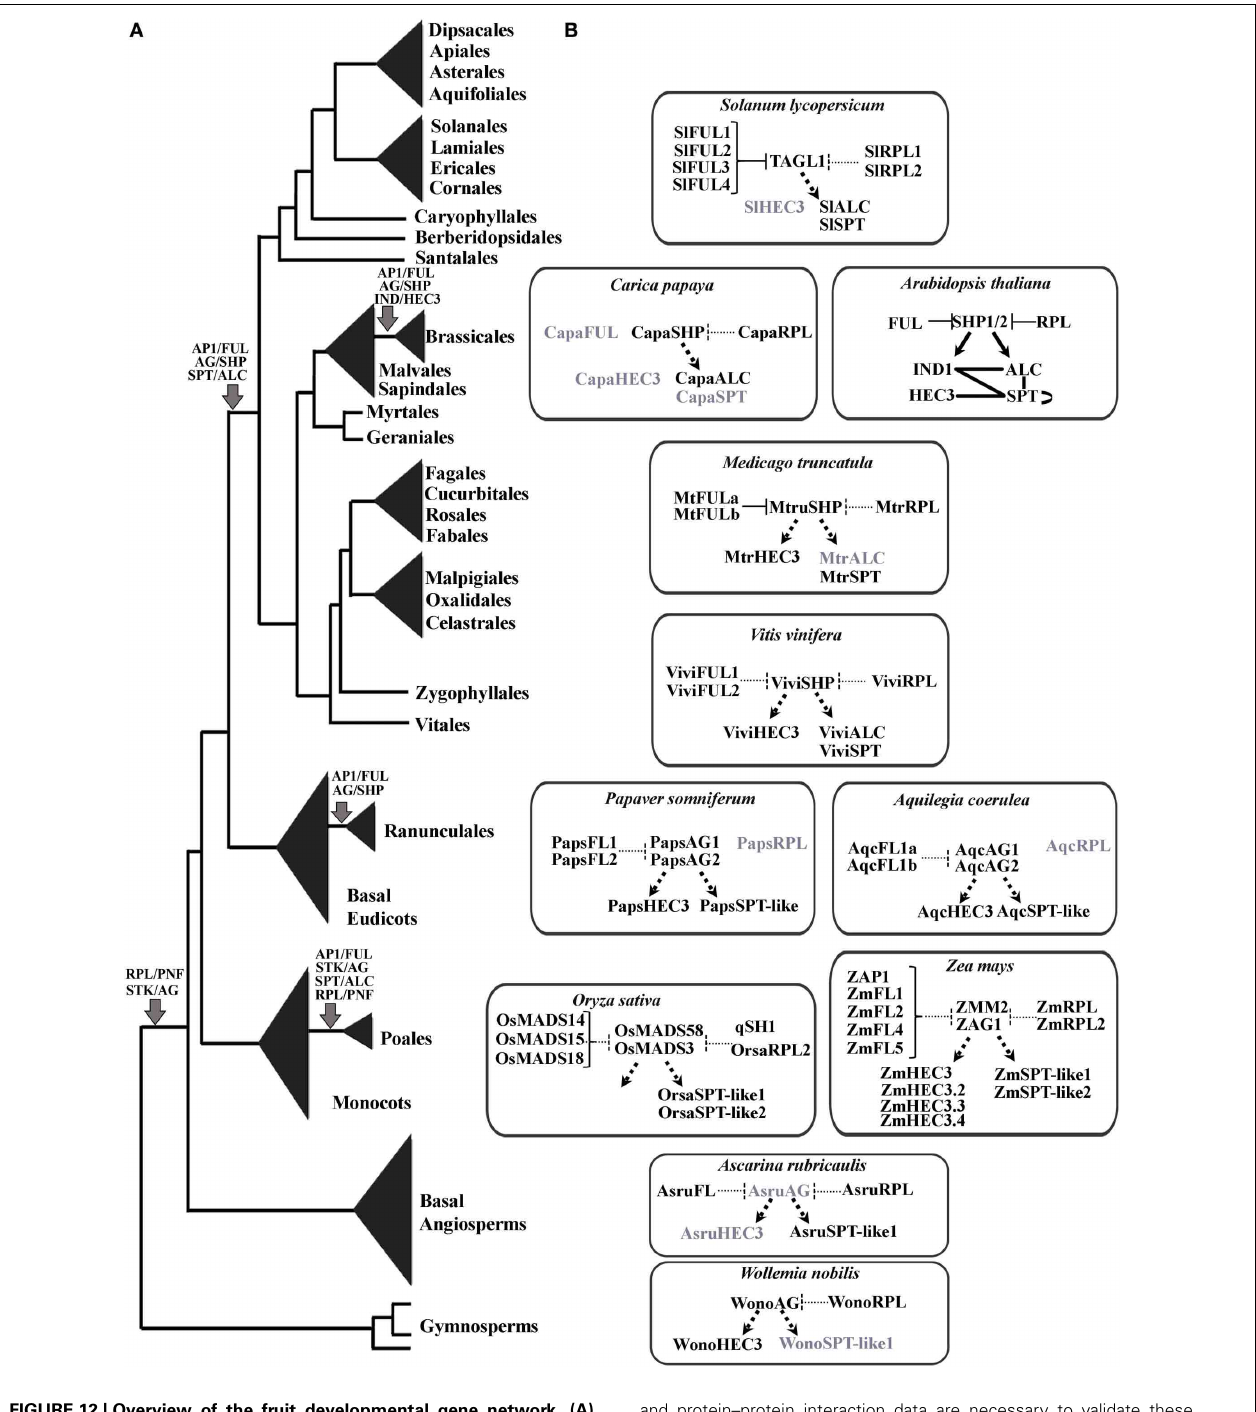
and protein–protein interaction data are necessary to validate these hypothetical interactions. Proteins in black are those previously identified or recovered in our analyses. Proteins in gray were not recovered from databases and may have been lost in the respective taxa. Solid black lines, validated protein–protein interactions; solid black arrows, validated activation; solid T-bars, validated repression; dashed lines, putative protein–protein interactions; dashed arrows, putative activation interactions; dashed T-bars, putative repression.